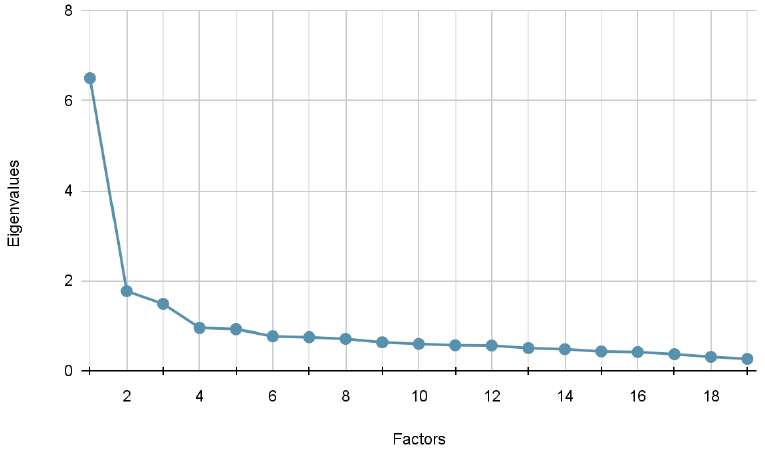
Figure 1. Scree test used for the EFA.